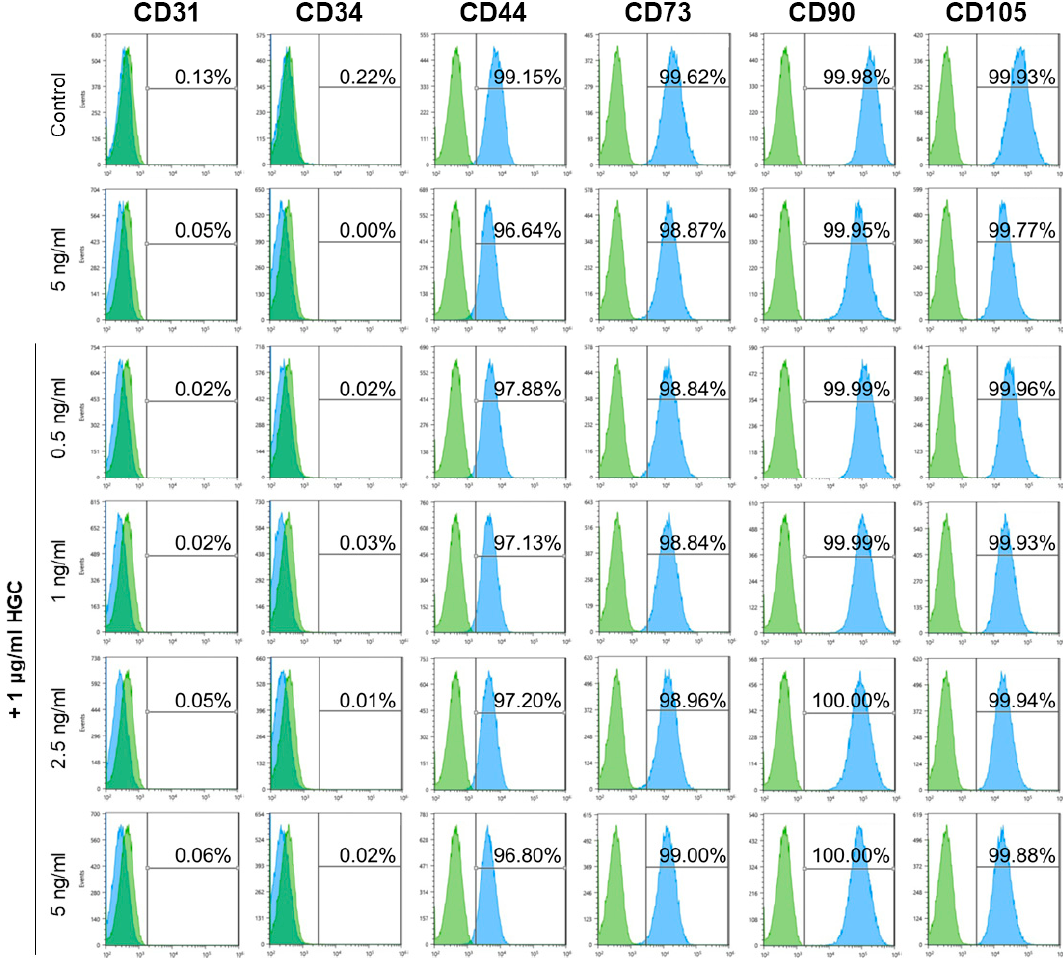
Figure 7. Characterization of AD-MSCs phenotypes by fluorescence-activated cell sorting (FACS) after long-term culture (passage 10).